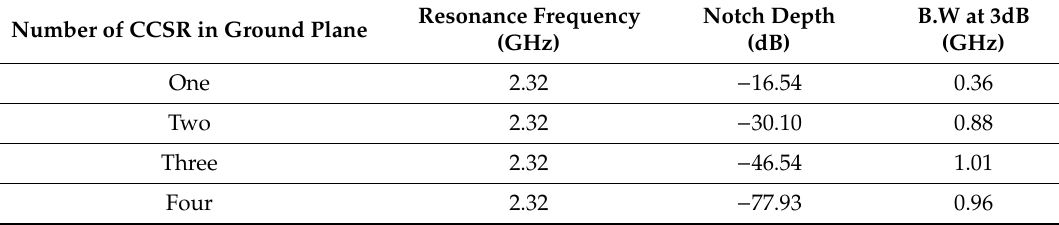
Figure 7. Distribution of electric field at resonance of proposed sensor based on ( a ) one CCSR, ( b ) two CCSR, ( c ) three CCSR, and ( d ) four CCSR. Table 2. Effect of CCSR number on resonance frequency, notch depth, and bandwidth.